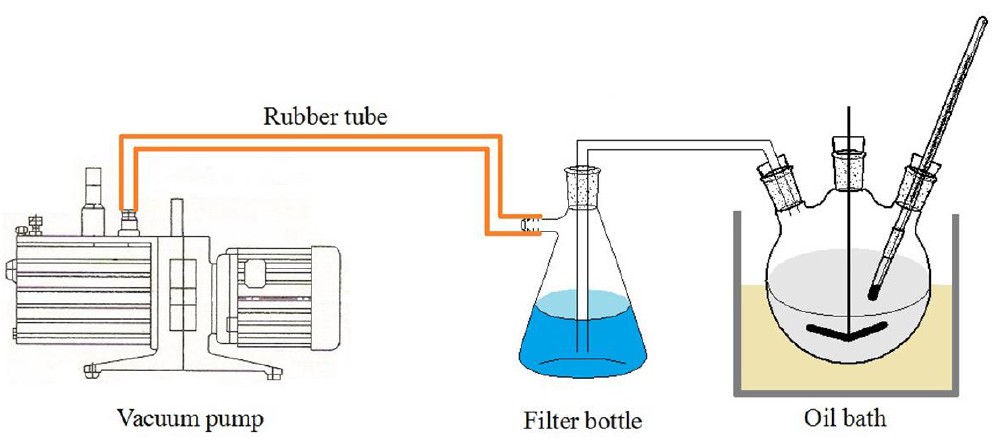
Figure 2. The schematic of the preparation of the initiator C10.